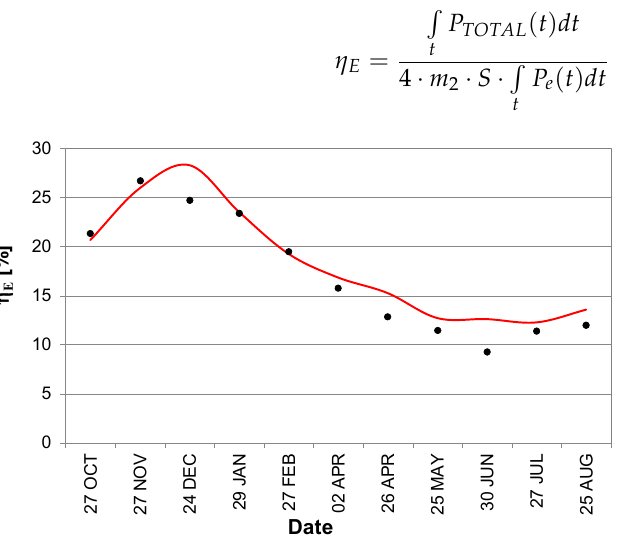
Figure 8. Measured and computed values of the energy efficiency of the considered photovoltaic installation on selected days.